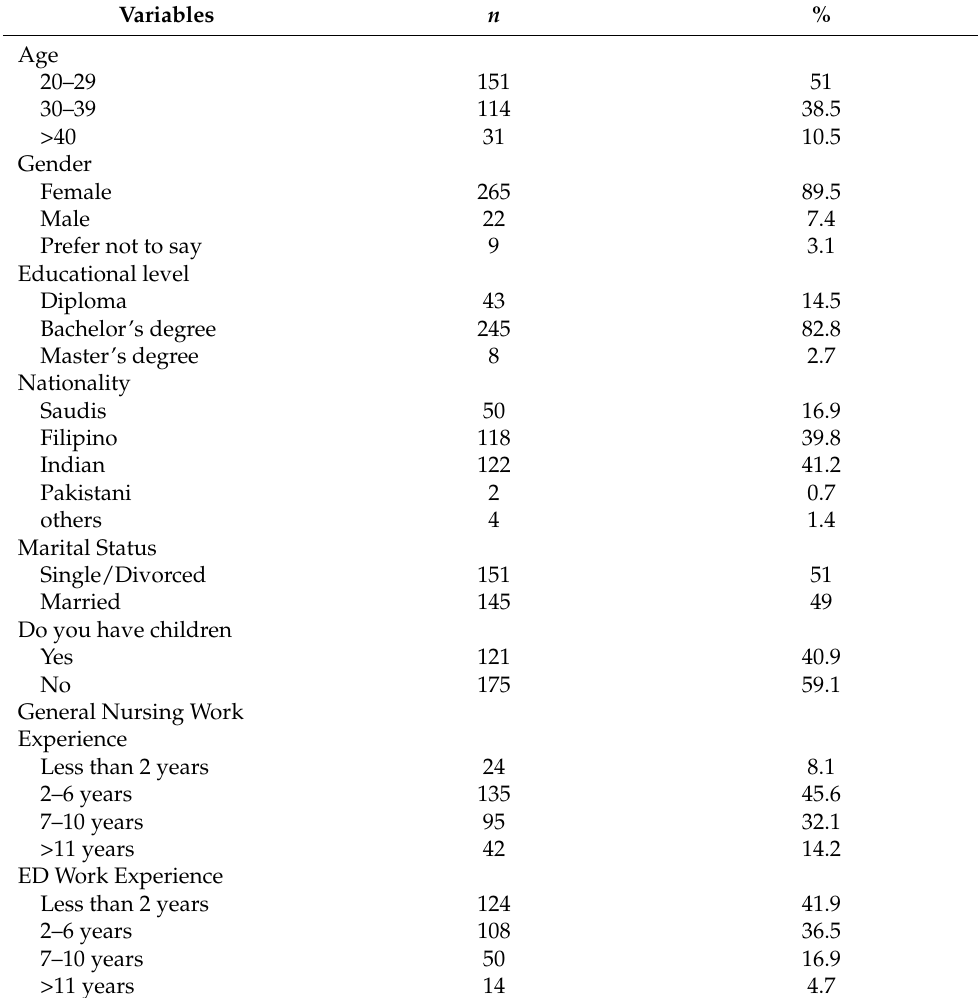
Table 2. Socio-demographic characteristics of participants ( n =